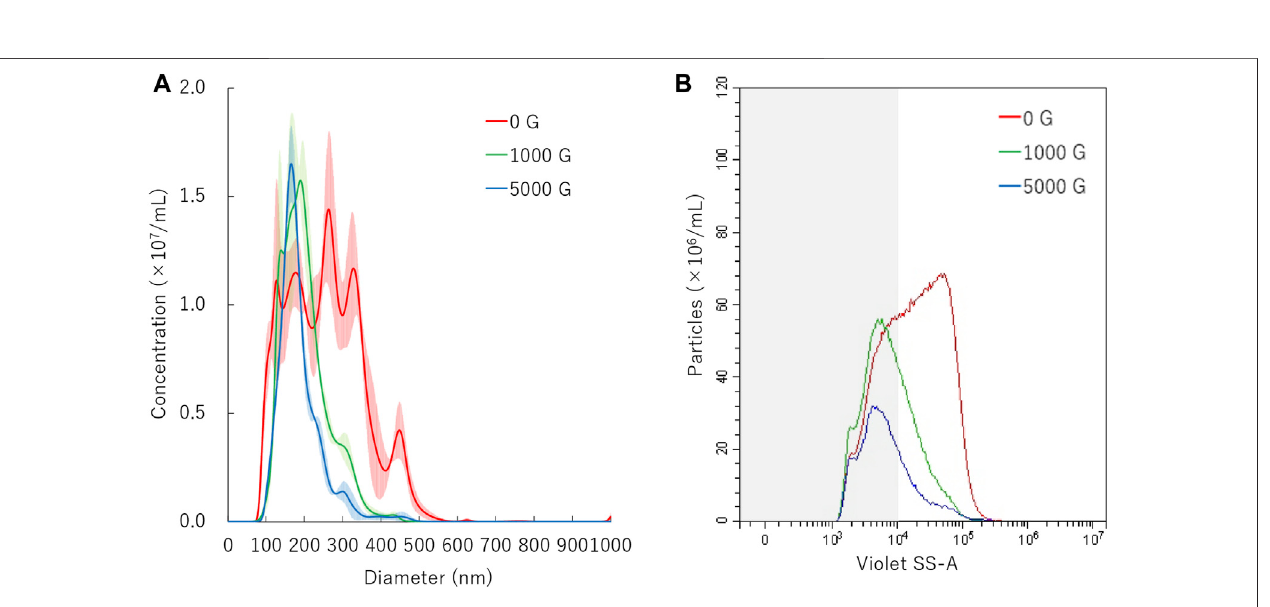
Frontiers in Pharmacology |